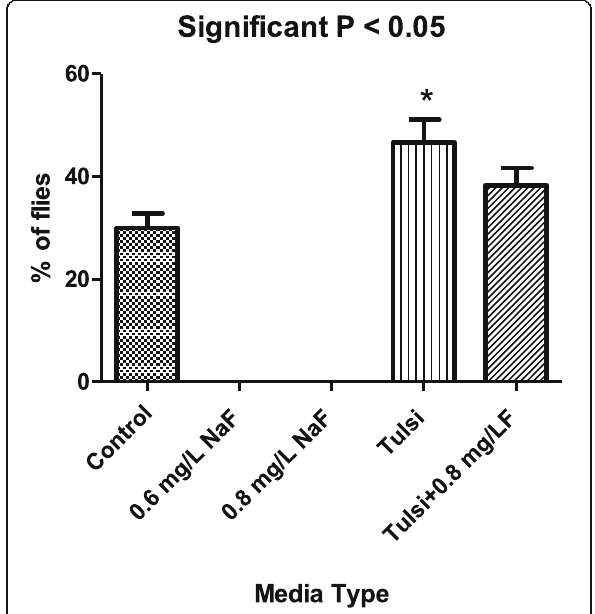
Fig. 6 Climbing ability of Drosophila melanogaster after 15 days of eclosion. *, significant difference between control vs tulsi